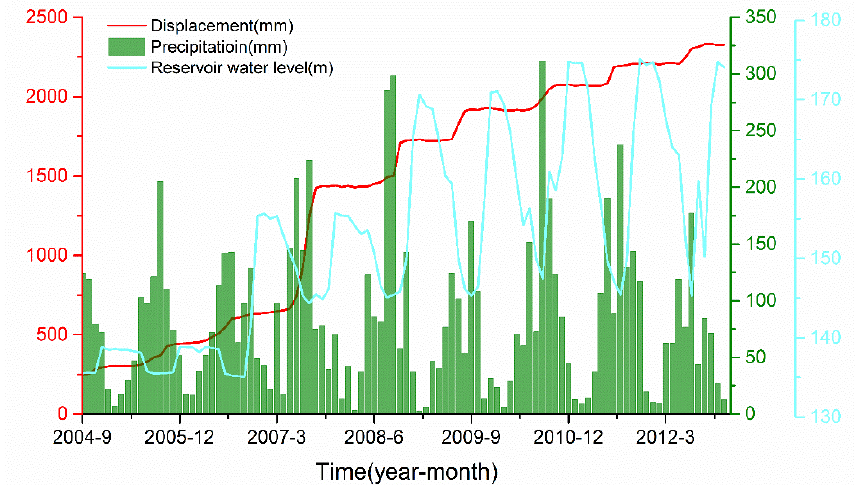
Figure 6. Relationship between the displacement of Baishuihe landslide and external environmental factors.